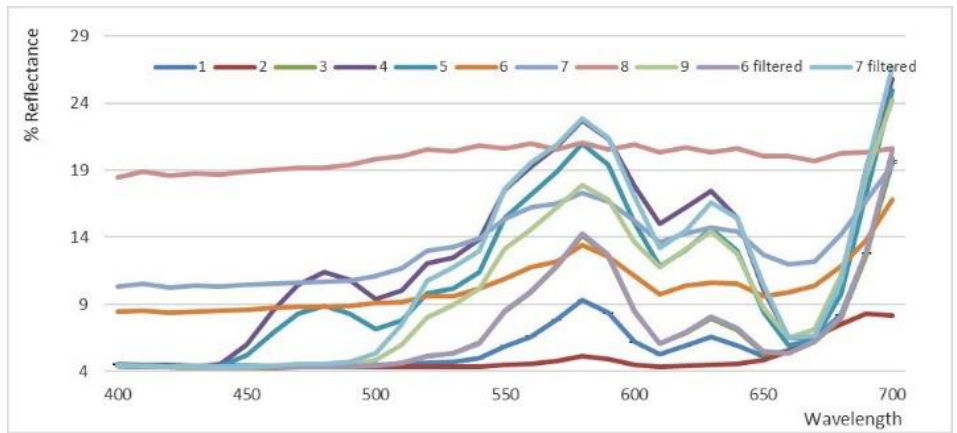
Figure 1. Spectral reflectance curves obtained by CIEL*a*b* analyses applied to 1–9 hemp seed oils. Samples 6 and 7 were measured after filtration.